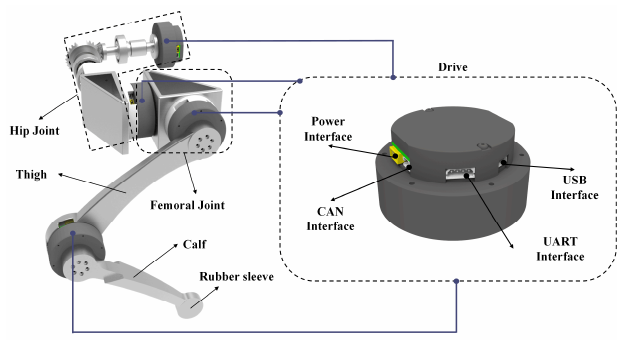
Figure 1. Leg structure and actuator.